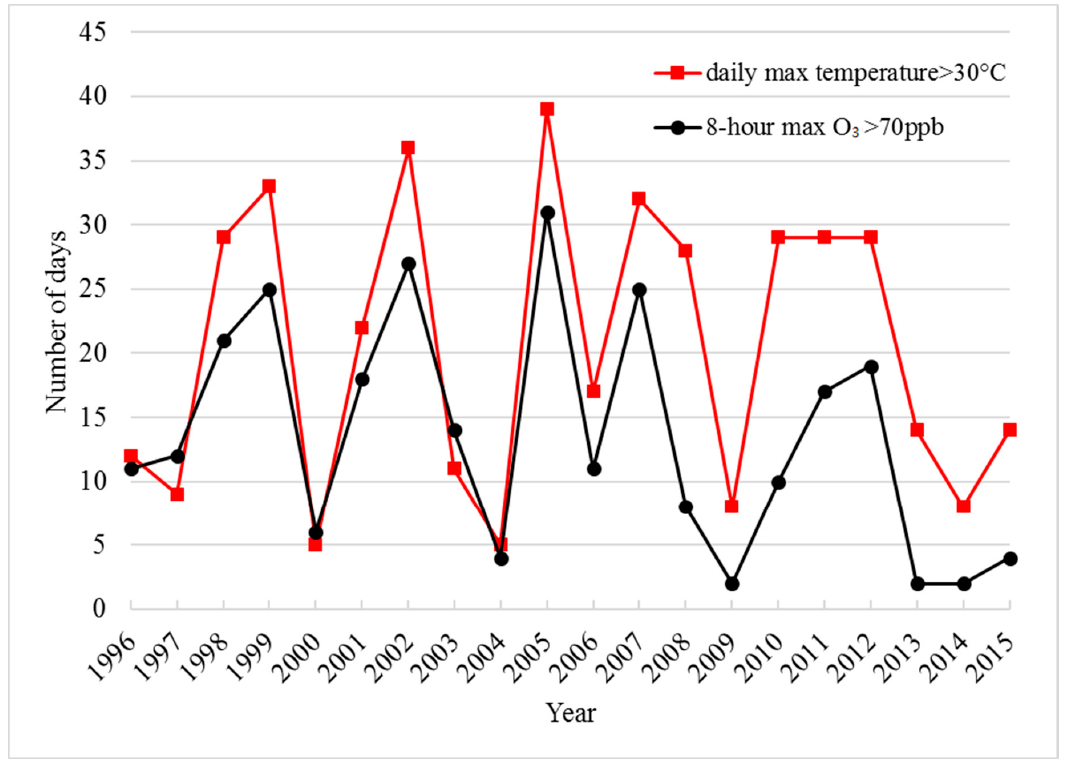
Figure 4. Number of days of smog season 8 h max O 3 greater than 70 ppb and number of daily max temperature greater than 30 °C in each year in Windsor during 1996–2015.